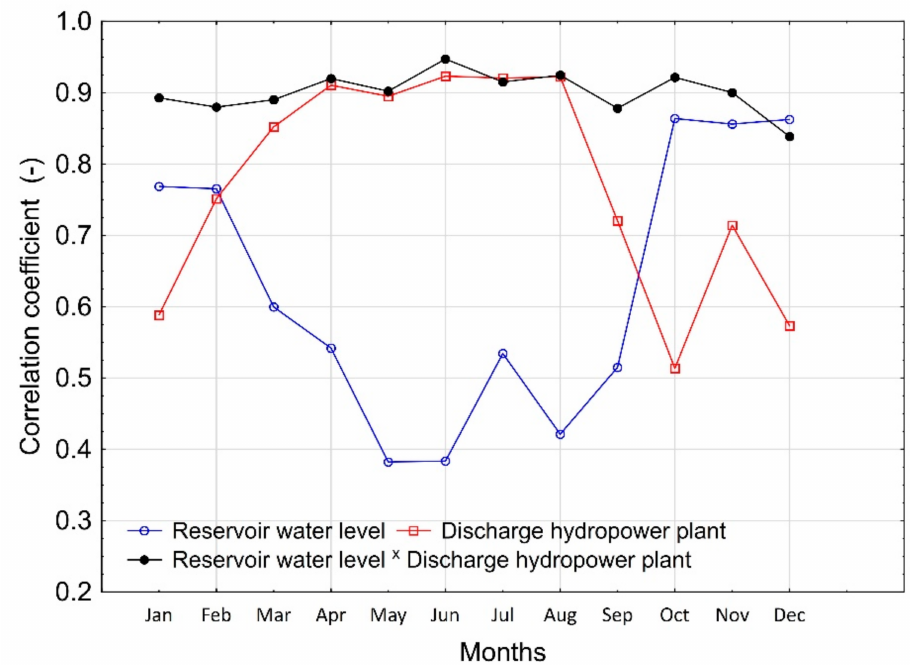
Figure 11. Analysis of the correlation coefficient between energy production by the Jeziorsko hy- dropower plant and selected hydrological